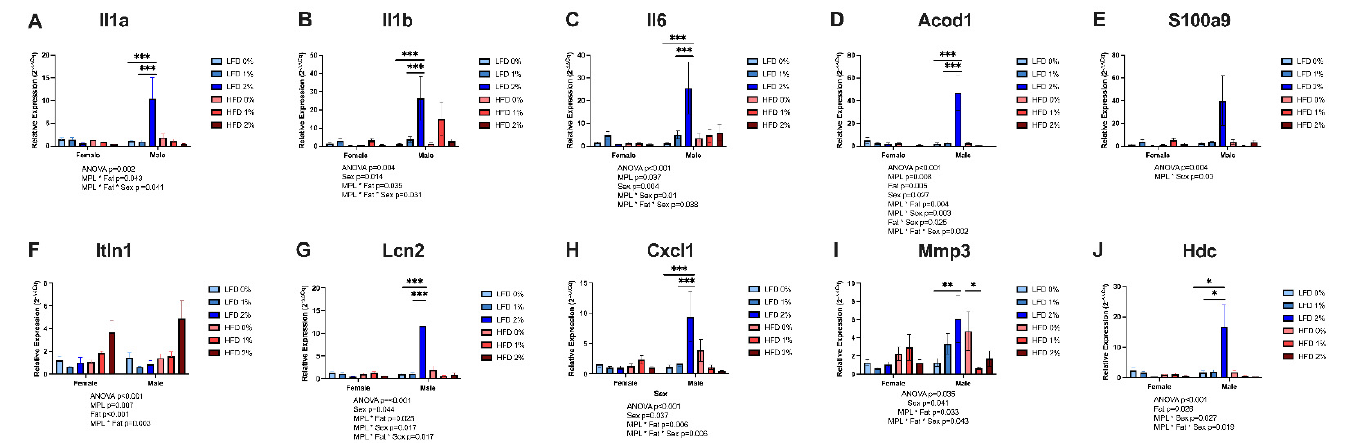
Figure 4. Effect of MPLs on colon gene expression. Colonic RNA gene expression was determined using real-time qRT-PCR and standardized to the geometric mean of Gapdh, Actb ( β -actin), and Rplp0 reference genes using the 2 −ΔΔ Ct method. ( A ) Interleukin (IL)-1 α (Il1a), ( B ) IL-1 β (Il1b), ( C ) IL- 6 (Il6), ( D ) aconitate decarboxylase (Acod1), ( E ) S100a9, ( F ) intelectin 1 (Itln1), ( G ) lipocalin 2 (Lcn2), ( H ) CXC motif chemokine receptor 1 (Cxcl1), ( I ) matrix metallopeptidase 3 (Mmp3), and ( J ) histidine decarboxylase (Hdc). Values are reported as mean ± standard error of the mean, n = 4–7/group. * indicates p -value < 0.05, ** indicates p -value < 0.01, and *** indicates p -value < 0.001 using three-way ANOVA with Fisher’s least significant difference for multiple comparisons.